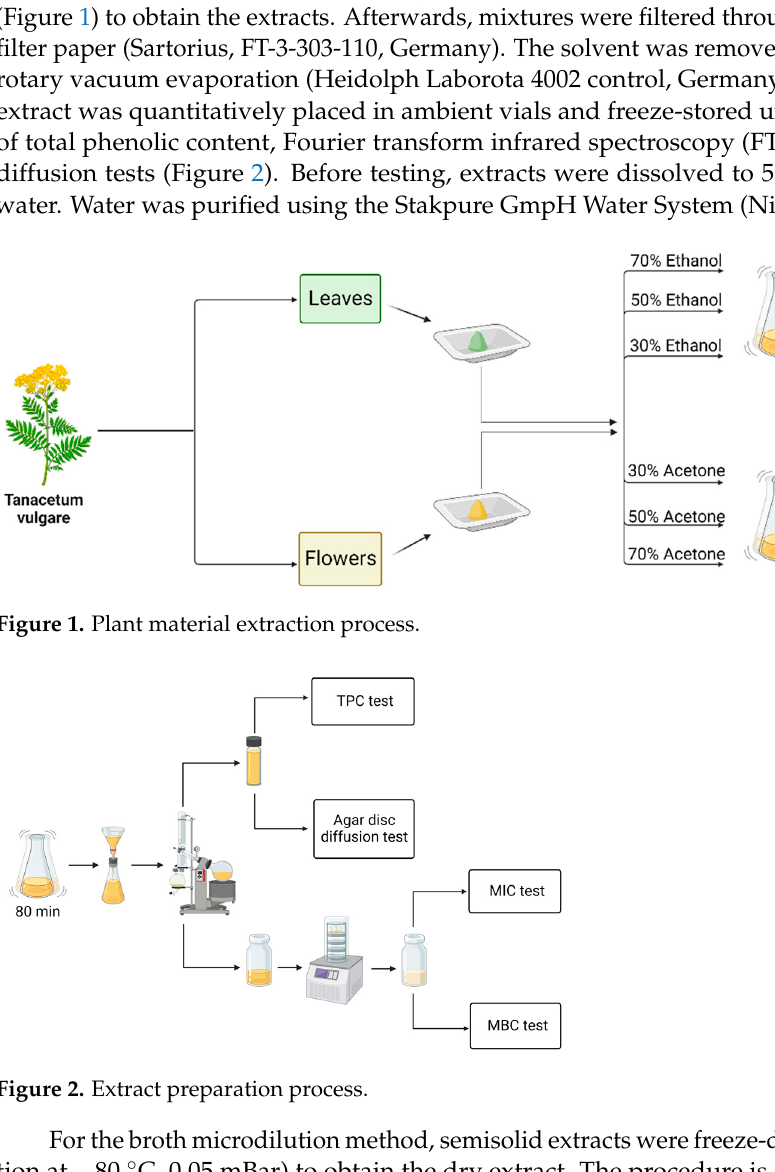
Figure 2. Extract preparation process.